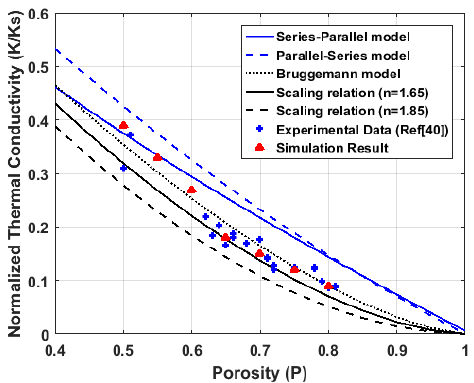
Figure 3. Models’ predictions and measurement and simulation value of thermal conductivity of metal-foam with different porosity.